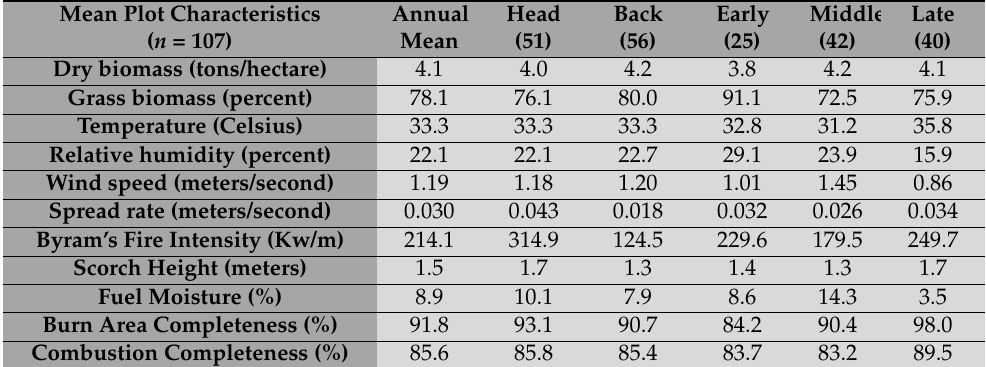
Table 1. Mean Plot and General Fire Characteristics by Study Period and Fire Type for all Fires in Tabou and Faradiele, Mali,